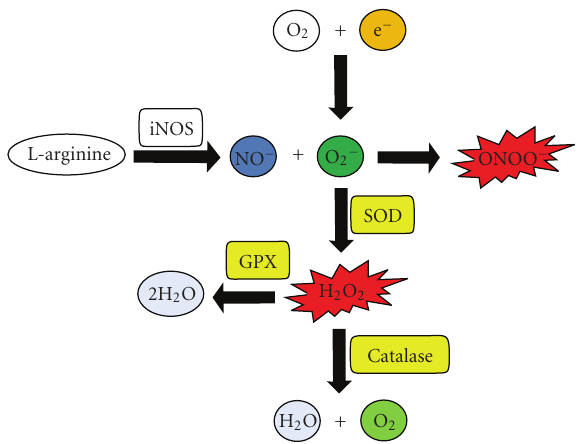
Figure 1: Cellular detoxification of reactive oxygen and nitrative species. Oxygen is reduced to superoxide (O − 2 ) during inflam- mation, and nitric oxide (NO − ) is generated by the action of inflammatory nitric oxide synthase (iNOS) on L-arginine. In the absence of detoxifying enzymes, NO − and O − 2 react to produce the highly toxic peroxynitrite (ONOO − ). Superoxide dismutase (SOD) competes for the superoxide anion and dismutes it to form hydrogen peroxide (H 2 O 2 ) which can then be removed by the enzymes catalase and glutathione peroxidase